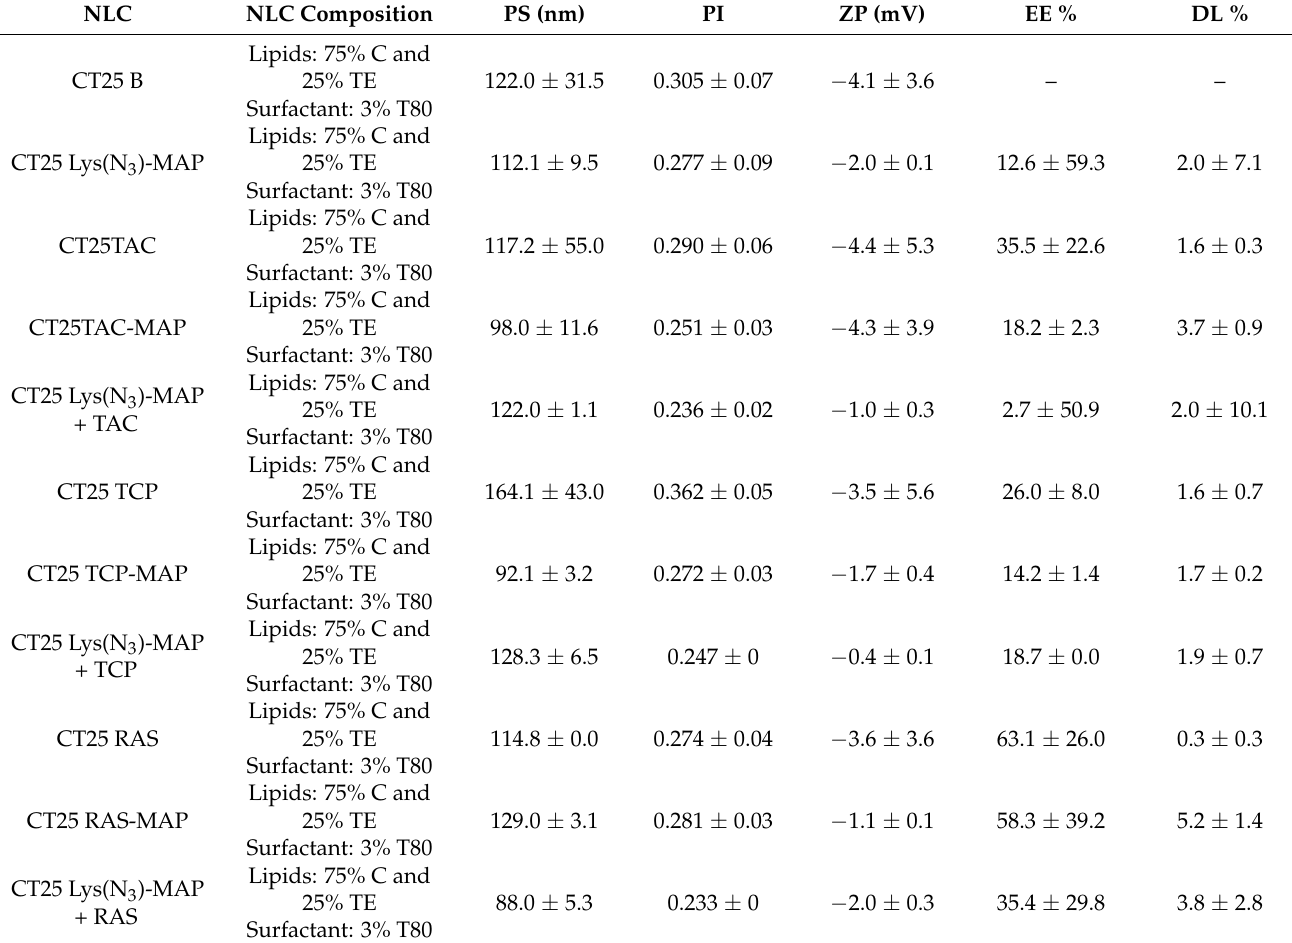
Table 1. Physicochemical properties of all NLCs formulated freshly (mean ± SD, n = 2 or